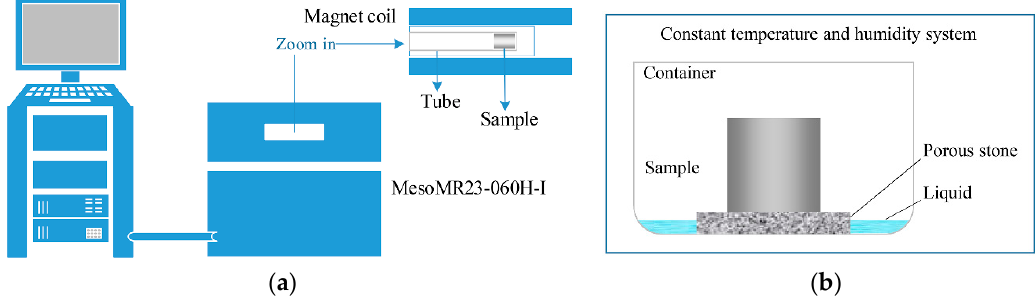
Figure 7. Spontaneous imbibition device. ( a ) Schematic plot of MesoMR23-060H-I; ( b ) schematic diagram of experiment.